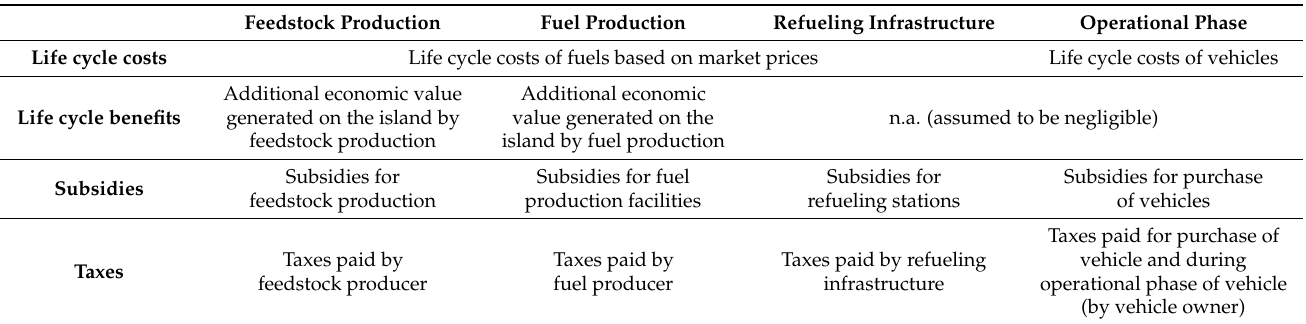
Table 5. Life cycle costs and benefits, subsidies and taxes under the relevant unit